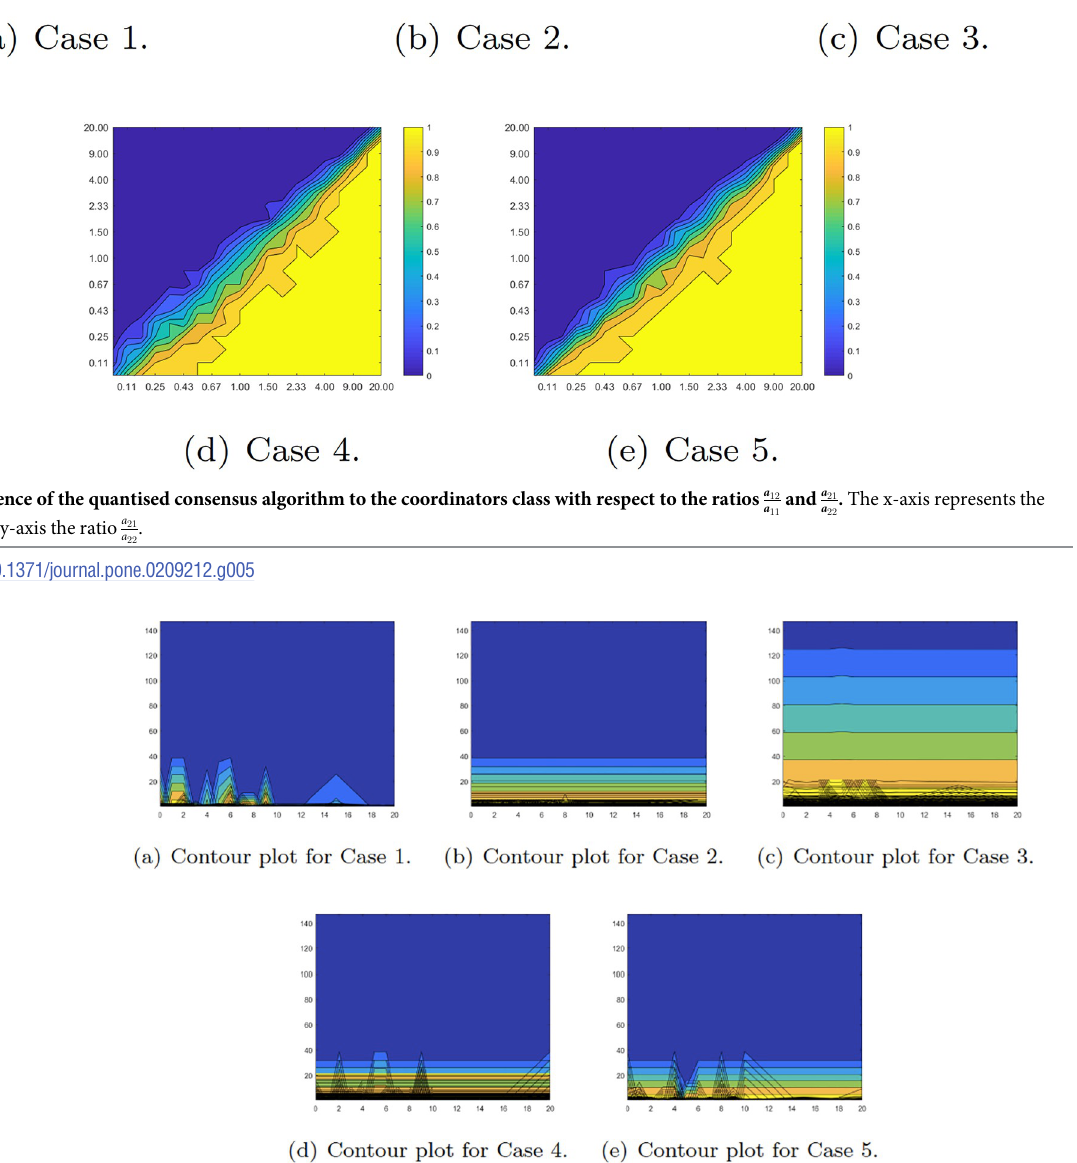
Fig 6. Simulation results for the X population when small world networks are considered. Dark blue colour denotes that quantised consensus and the markov chain resulted in the same decision in all the simulations. When yellow colour denotes that the results were the same only on the 40% of the cases. The x -axis corresponds to the minimum number of neighbours that an agent could have, in addition to the m neighbours which were necessary to have. The y -axis represents the various values of a 11 a 21 a 22 a 12